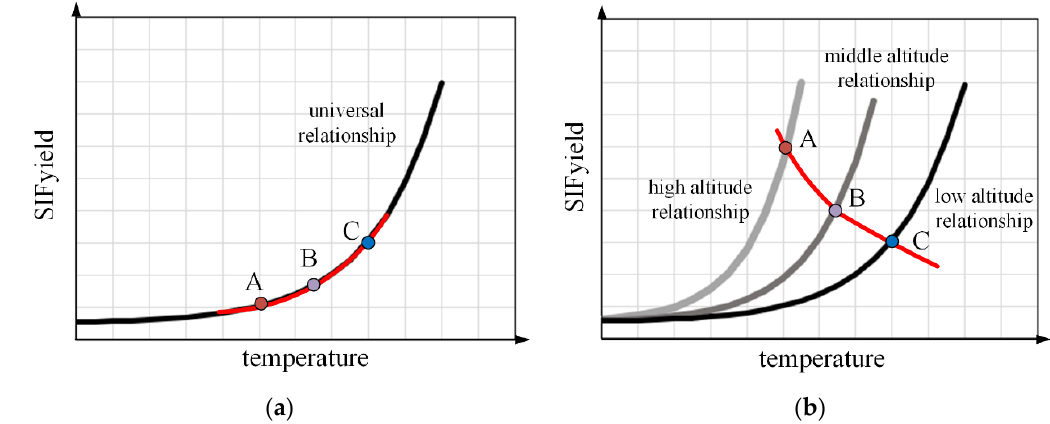
Figure 9. Schematic diagrams showing that temperature sensitivity makes high SIF yield at high altitudes possible. ( a ) Altitu- dinal patterns of SIF yield when there is no altitudinal variation of temperature sensitivity. ( b ) Possible altitudinal patterns of SIF yield when accounting for altitudinal variation of temperature sensitivity. A, B, and C represent regions from high to low altitude, corresponding to temperature variation from low to